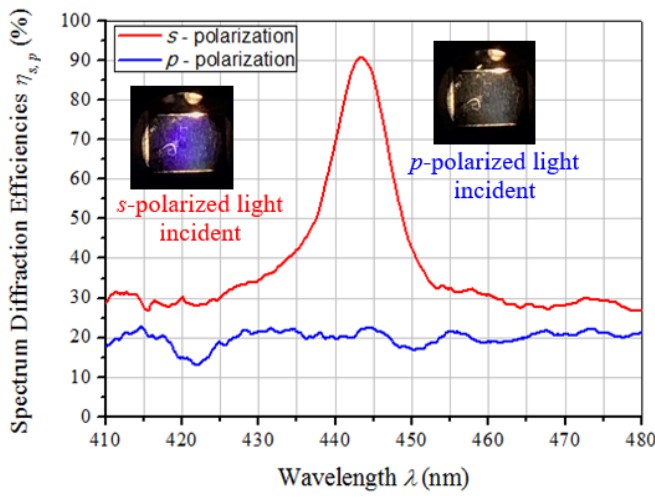
Figure 7. Spectrum diffraction efficiencies for s - and p -polarizations and appearances with s - and p -polarized incident lights.